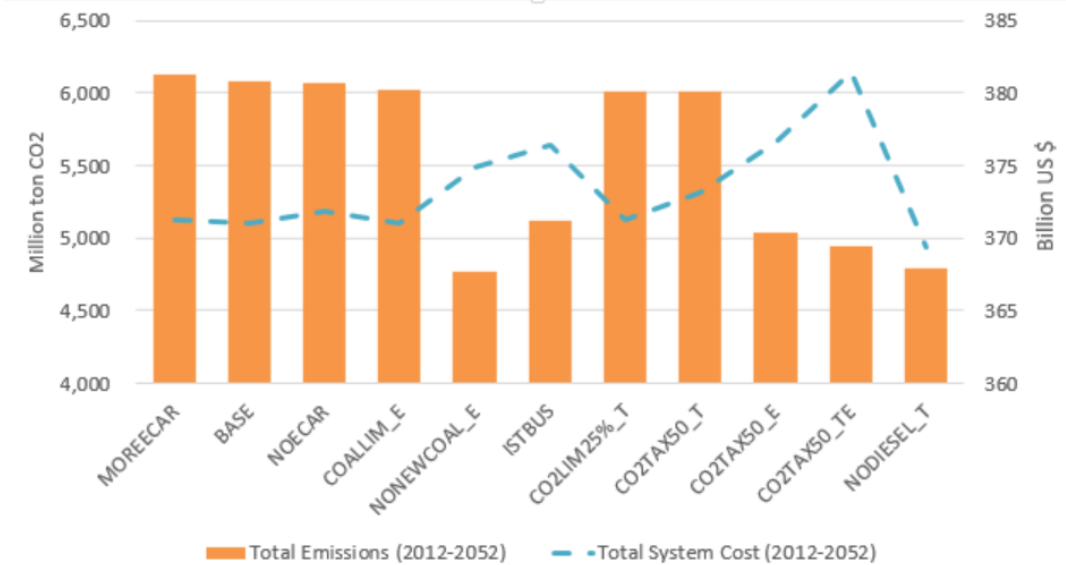
Figure 8. Total emissions and total system cost by scenario throughout the planning